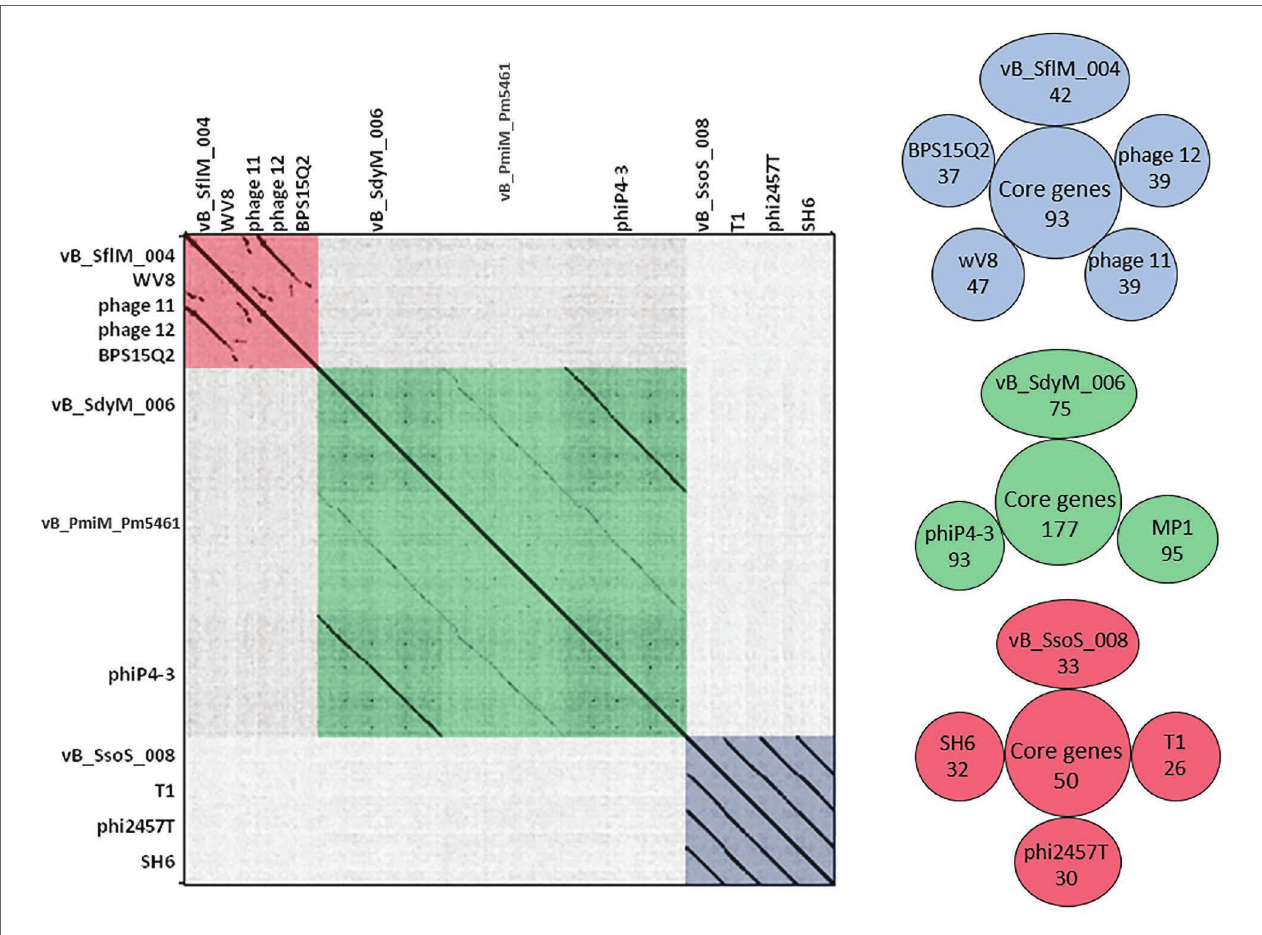
FIGURE 4 | (Left side) Dot plot alignment of the nucleotide sequences of the isolated phages vB _SflM_004, vB_SdyM_006, and vB_SsoS_008 with that of the close related phages. The FASTA file of 1,300,800 bp file was compared to itself using GEPARD. Dark diagonal lines parallel to the main diagonal shows strong and continuous sequence similarity, while pale lines indicate weaker sequence relationships due to interruptions that result in a discontinuous line. The red, green, and blue boxes were added to illustrate the phage sequences related to vB _SflM_004, vB_SdyM_006, and vB_SsoS_008. (Right side) The shared conserved proteins of vB _SflM_004, vB_SdyM_006, and vB_SsoS_008 phages with their close related phages (SH6, Shfl1, ADB-2, JMPW2). Only the gene products with >75 score in CoreGenes analysis were considered as a